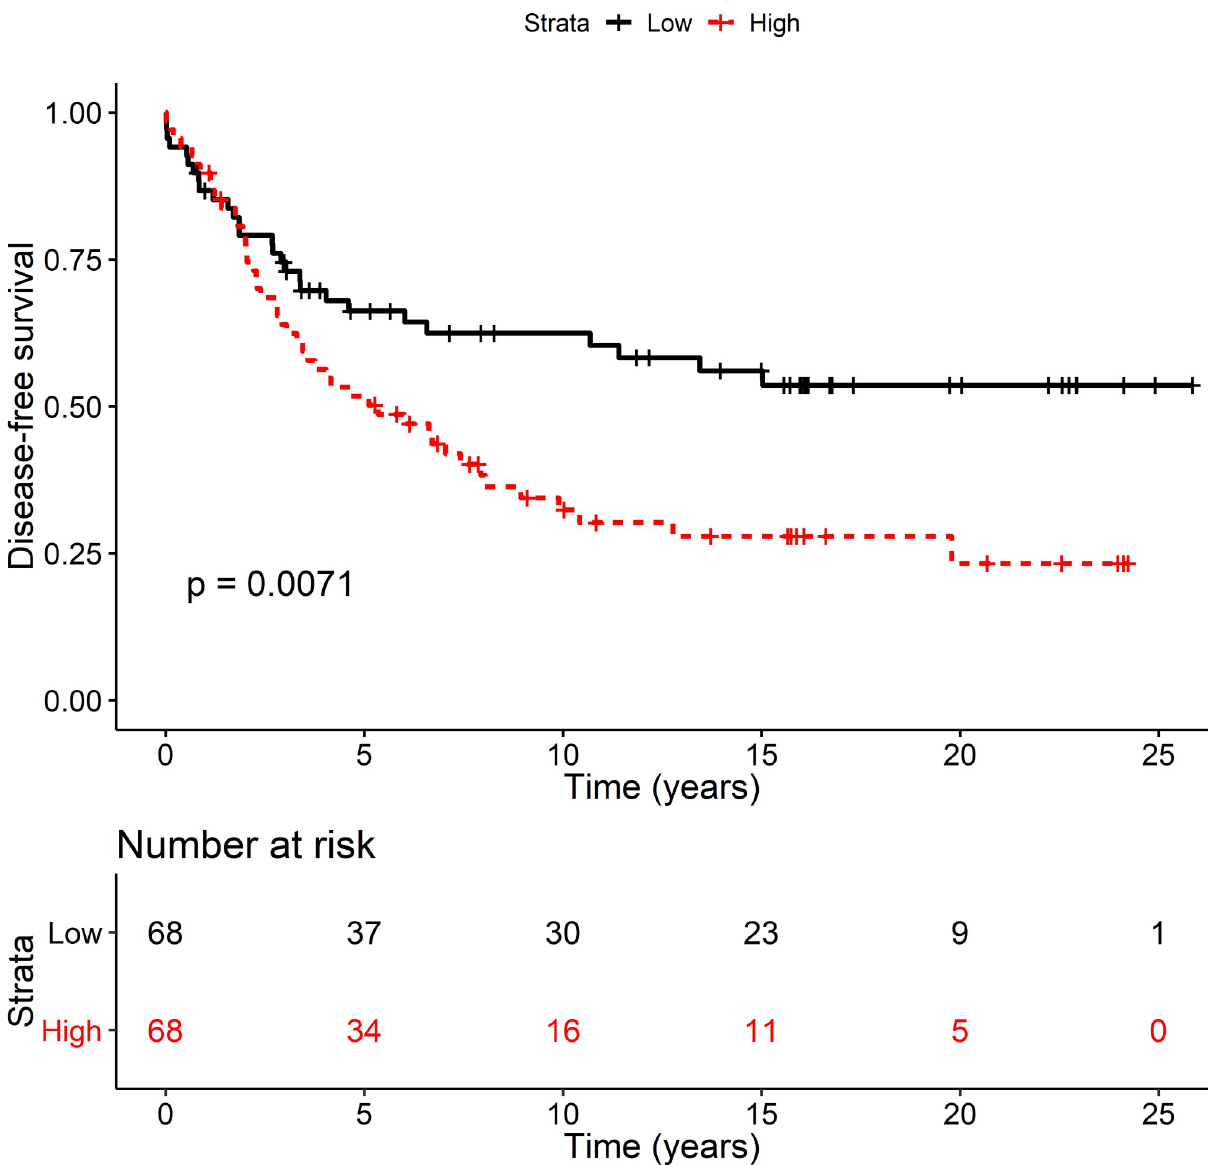
Fig 1. High miR-21-3p levels associated with shorter DFS. Disease-free survival (DFS) was examined in cohort-1, an exploration cohort. Patients were divided into two groups based on median expression of miR-21-3p; high reflects above the median expression (red) and low reflects below median expression (black). The log rank p-value was 7.1 . 10 − 3 . The number of patients at risk at the indicated time point is shown in a table below the graph. The DFS HR was 1.89 (CI 1.18–3.04) and after adjusting for HER2 the HR was 1.72 (CI 1.08–2.78).